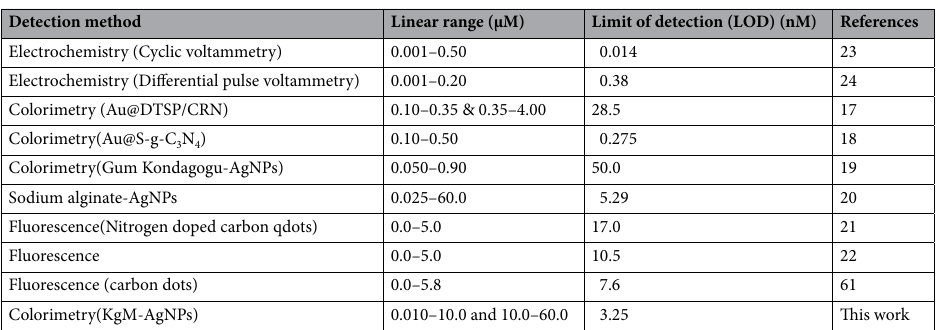
Table 1. Comparison of KgM-AgNPs sensor with reported works towards Hg 2+ detection in solution. Au@ DTSP/CRN = creatinine on 3, 3 ′ -dithiodipropionic acid di (N-hydroxysuccinimide ester) functionalized gold nanoparticles; Au@S-g-C 3 N 4 = gold nanoparticles assembled on Sulphur doped graphitic carbon; qdots = quantum dots.